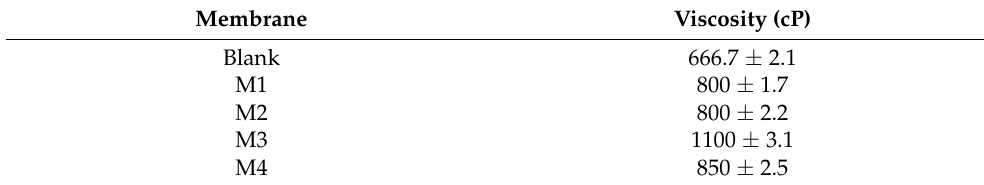
Table 4. Viscosity of dope solution prepared.